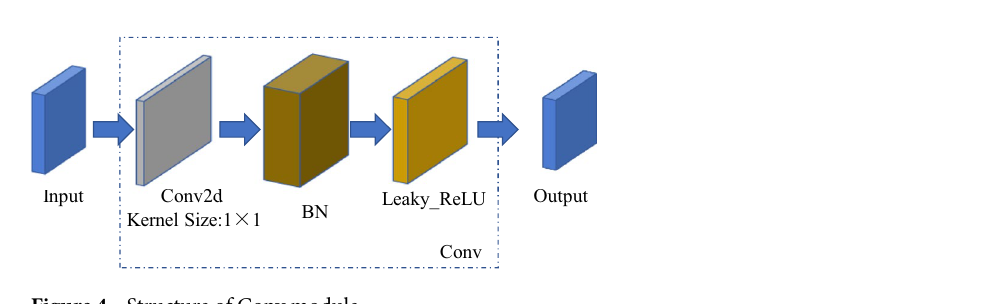
Figure 4. Structure of Conv module.